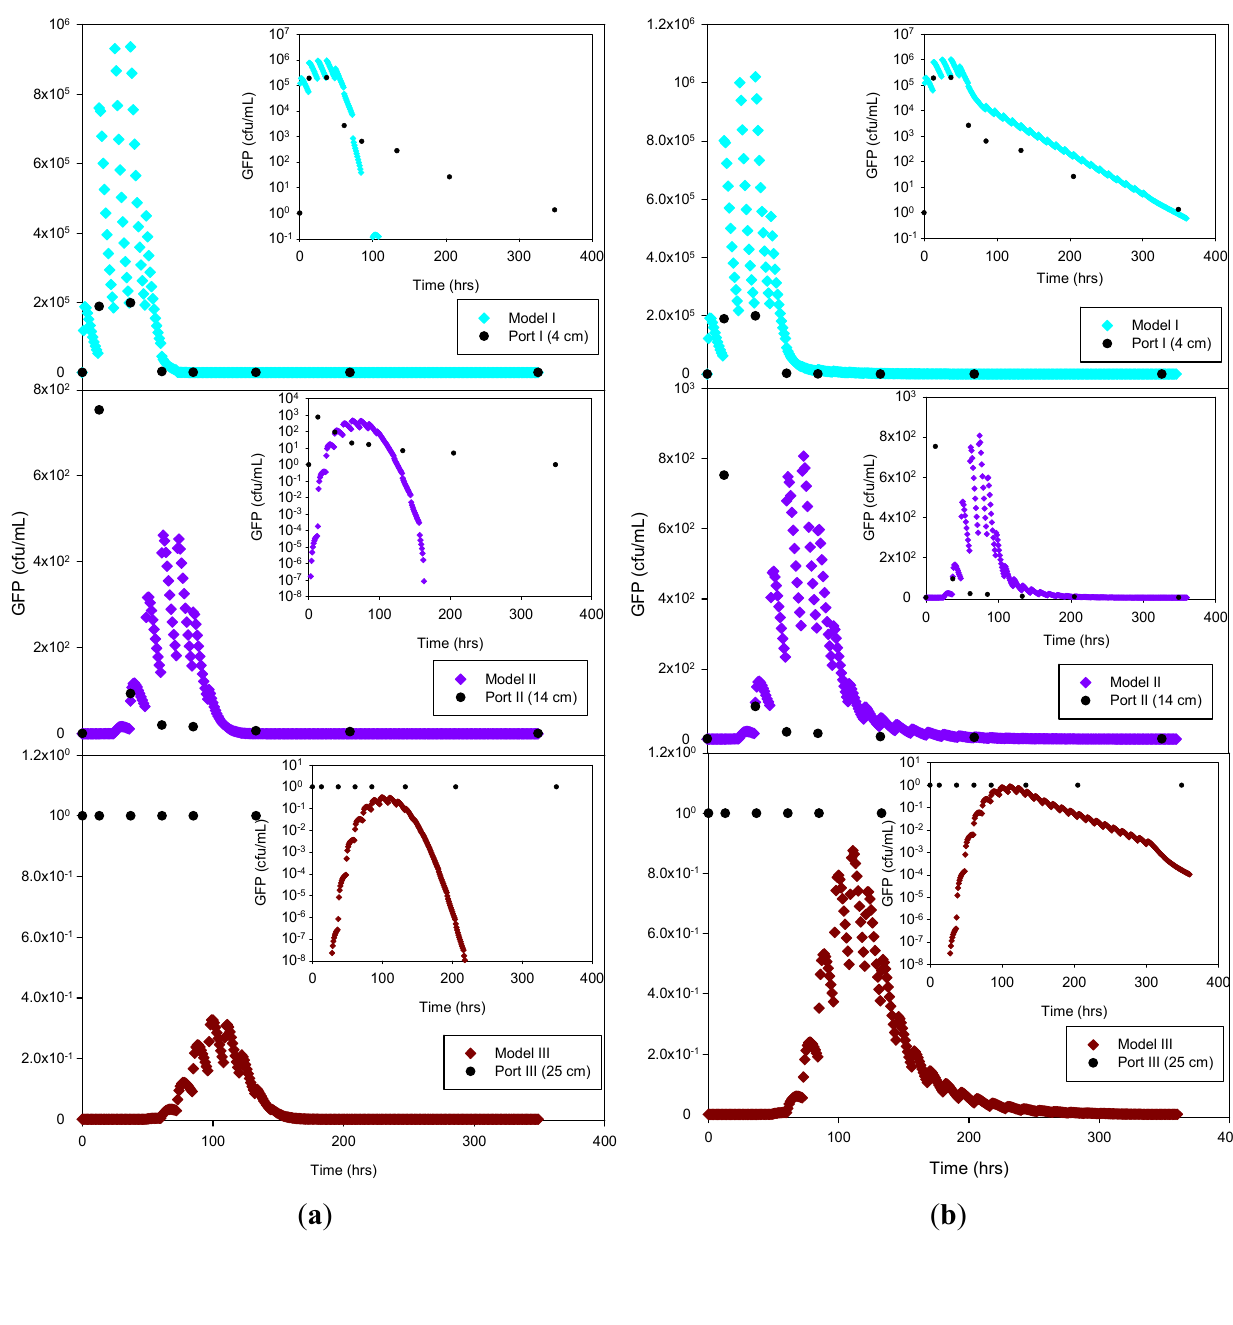
Figure 6. Experimental GFP E. coli data and HYDRUS optimization ( a ) and trial-and-error ( b ) simulation for the clay loam soil at 4 cm, 14 cm and 25 cm depth. The log-normal inserts emphasize the tailing